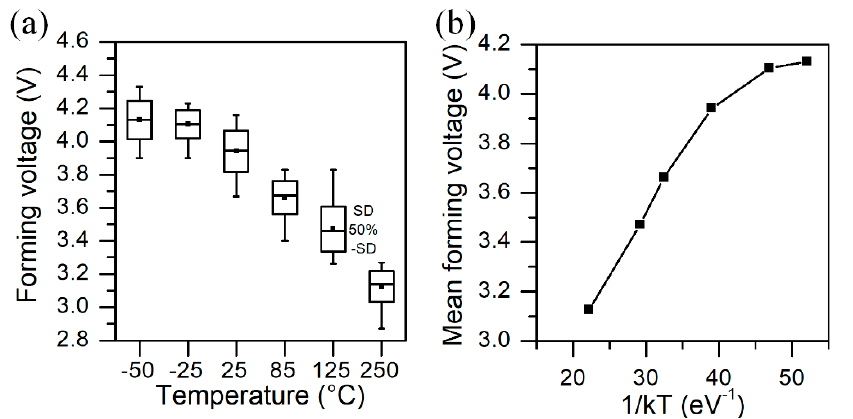
Figure 3. Forming voltage statistics ( a ) and mean forming voltage values ( b ) at different temperatures.